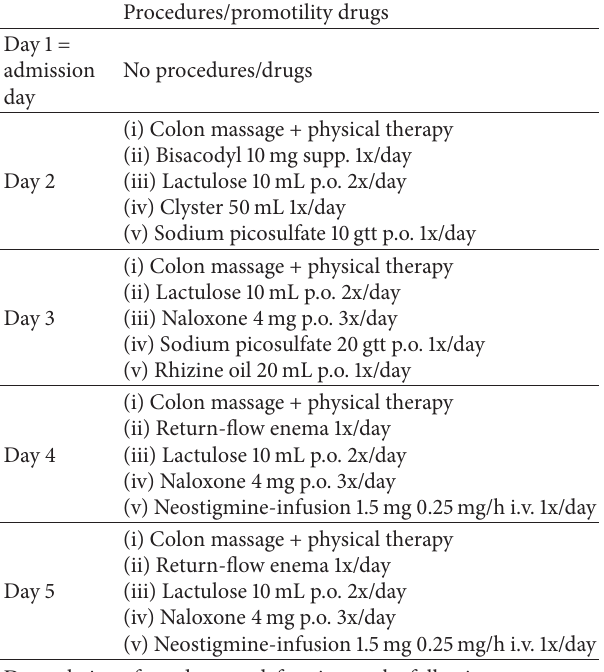
Table 1: SOP: promotility procedures for adult patients with acute severe brain disorder and expectable prolonged ventilation for more than 3